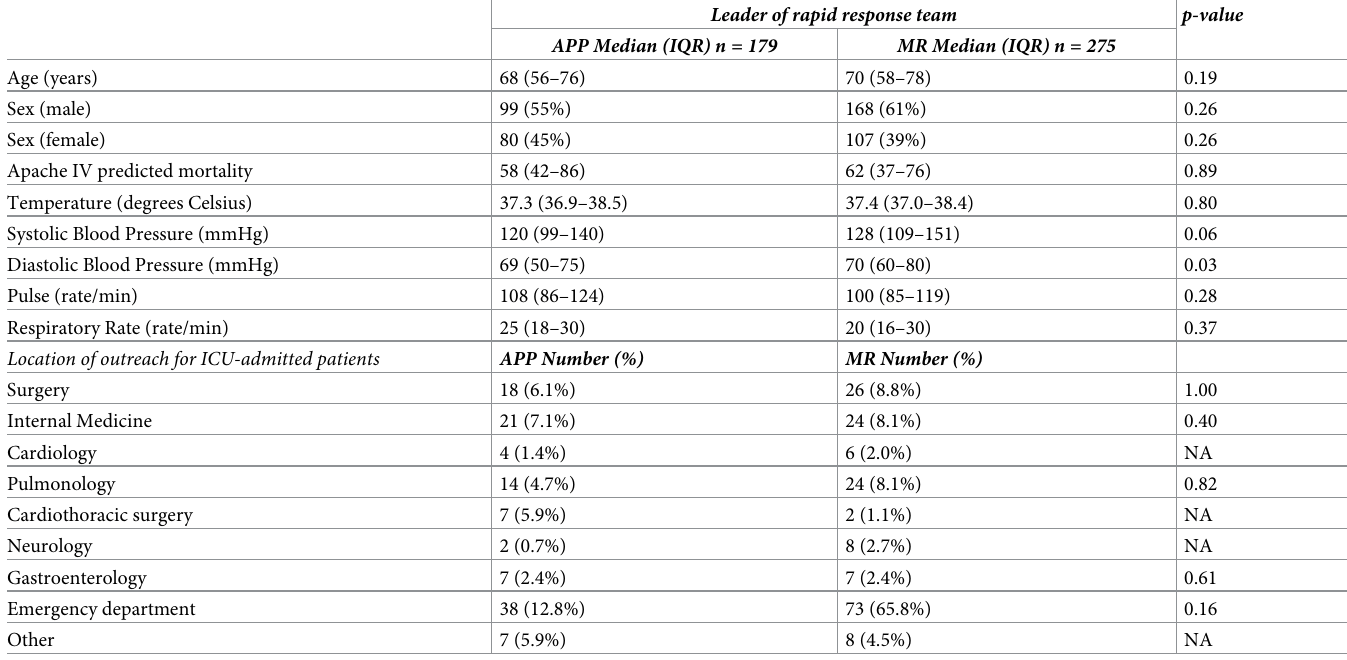
Table 1. Patient characteristics on arrival of the rapid response team. Data are given as numbers with percentages or as medians with